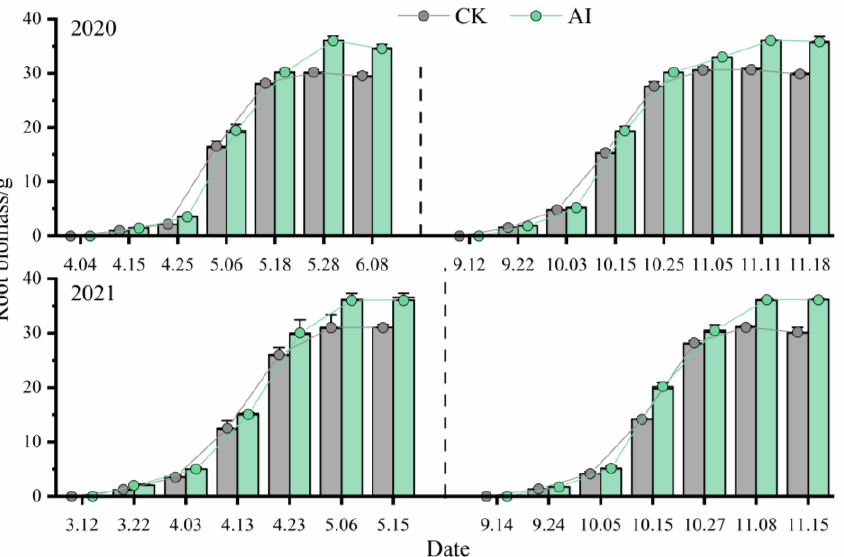
Figure 7. Changes in maize root biomass factors under different treatments (AI, aerated irrigation; CK, unaerated subsurface drip irrigation).